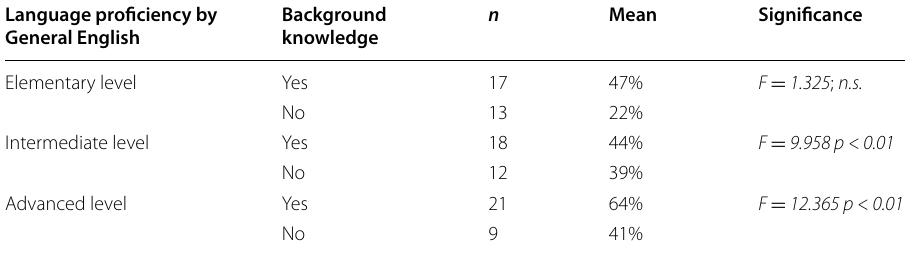
Table 7 Reading test (text 2) according to language proficiency (General English) and background knowledge: comparison of